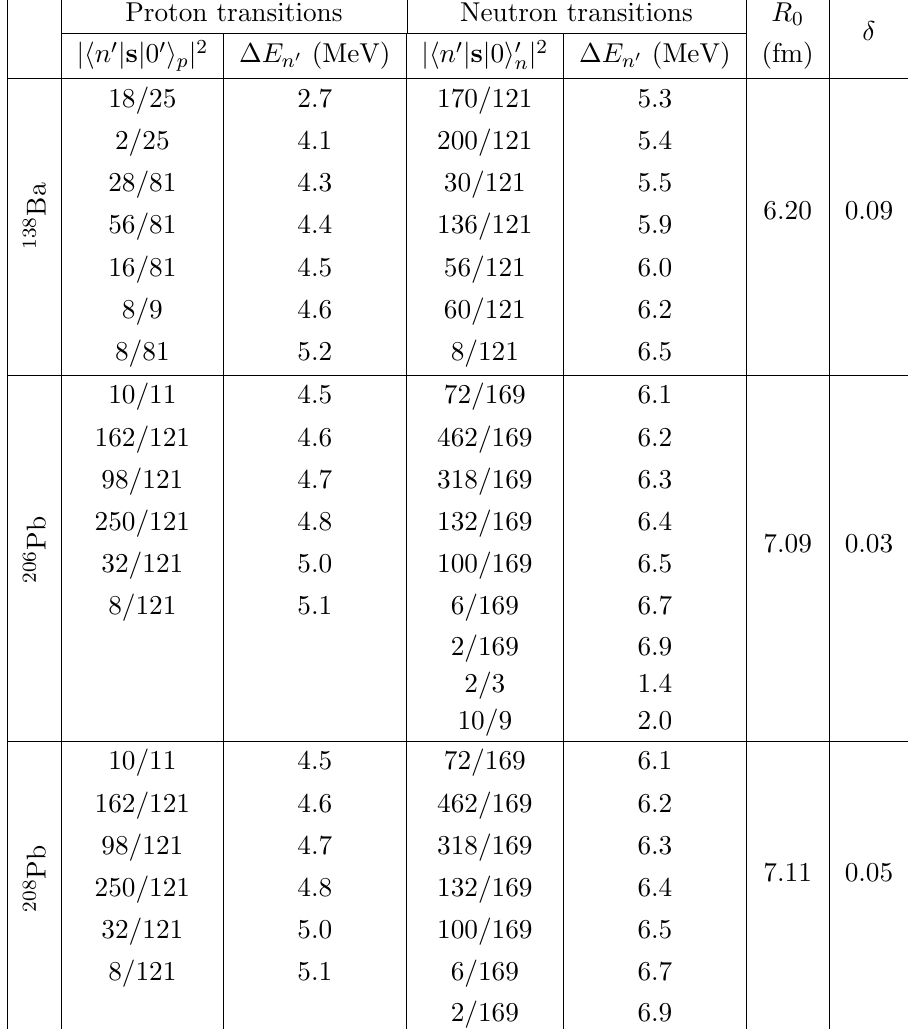
neutron contributions come from h 5 h 9 j s j 5 h 11 i . All these matrix elements may be calcu- 2 2 lated using the properties of spherical spinors (see, e.g., ref. [74]). The energies of all these transitions may be estimated with the use of (cid:12)gure 5 in ref. [75]. When the energies